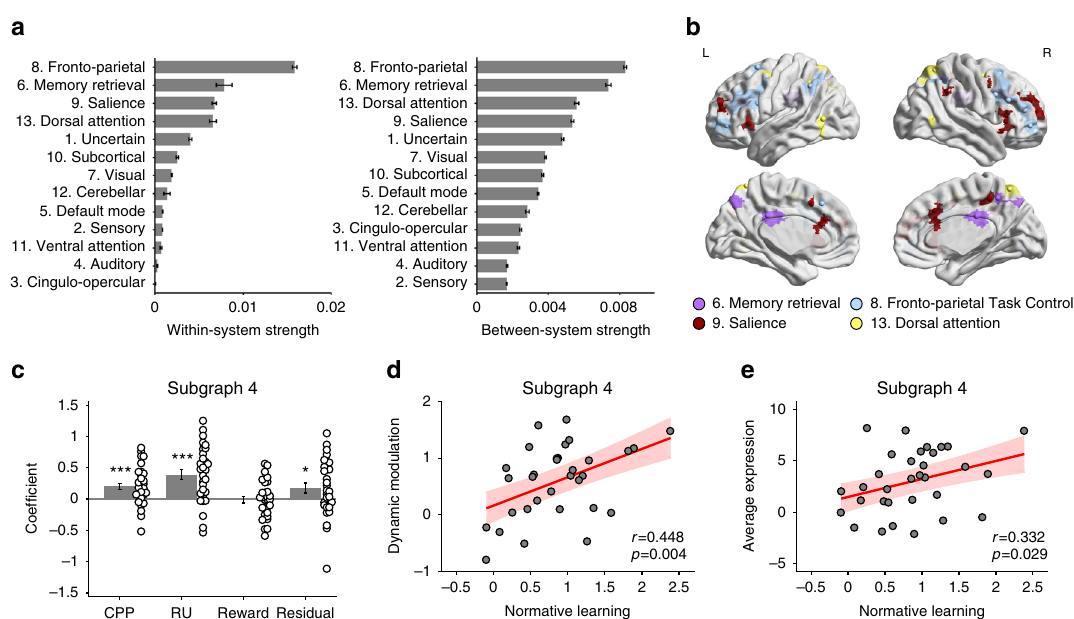
Fig. 4 Temporal expression of subgraph 4 was related to task factors and individual differences. a Summary of the pattern of connectivity in subgraph 4. We summarized the pattern of connectivity as within-system strength (which is the value in the diagonal) and between-system strength (which is the average of values in the off-diagonal) for each system. The fronto-parietal system as well as three other systems (memory retrieval, salience, and dorsal attention) showed the strongest contributions to this subgraph in terms of both within-system and between-system strength. The 95% con fi dence interval of each system was estimated by boostrapping 10,000 times on the edges of that system. b Nodes for the top four systems with strong within-system and between-system strength. We showed the nodes of fronto-parietal system, memory retrieval system, salience system and dorsal attention system on the brain by the BrainNet Viewer 42 under the Creative Commons Attribution (CC BY) license (https://creativecommons.org/licenses/by/4.0/). c Modulation of temporal expression of subgraph 4 by task factors. A regression model that included CPP, RU, reward, and residual updating as predictors of temporal relative expression (calculated by subtracting negative expression from positive expression) of subgraph 4 was fi tted for each participant, and coef fi cients were tested on the group level by t tests. The results showed positive effects of CPP, RU, and residual updating. Each point represents one participant. Error bars represent one SEM. (* p < 0.05, *** p < 0.001) d The relationship between individual normative learning and the dynamic modulation of subgraph 4 expression by normative factors. This dynamic modulation was indexed as the sum of the coef fi cients of CPP and RU in ( c ), and represents the extent to which trial-by-trial expression was in fl uenced by the two normative learning factors. There was a signi fi cant positive correlation across participants. Each point represents one participant. The red line represents the regression line and the shaded area represents the 95% con fi dence interval. e The relationship between individual normative learning and average relative expression of subgraph 4. There was a signi fi cant positive correlation across participants. Each point represents one participant. The red line represents the regression line and the shaded area represents the 95% con fi dence interval. Source data of c – e are provided as a Source Data fi